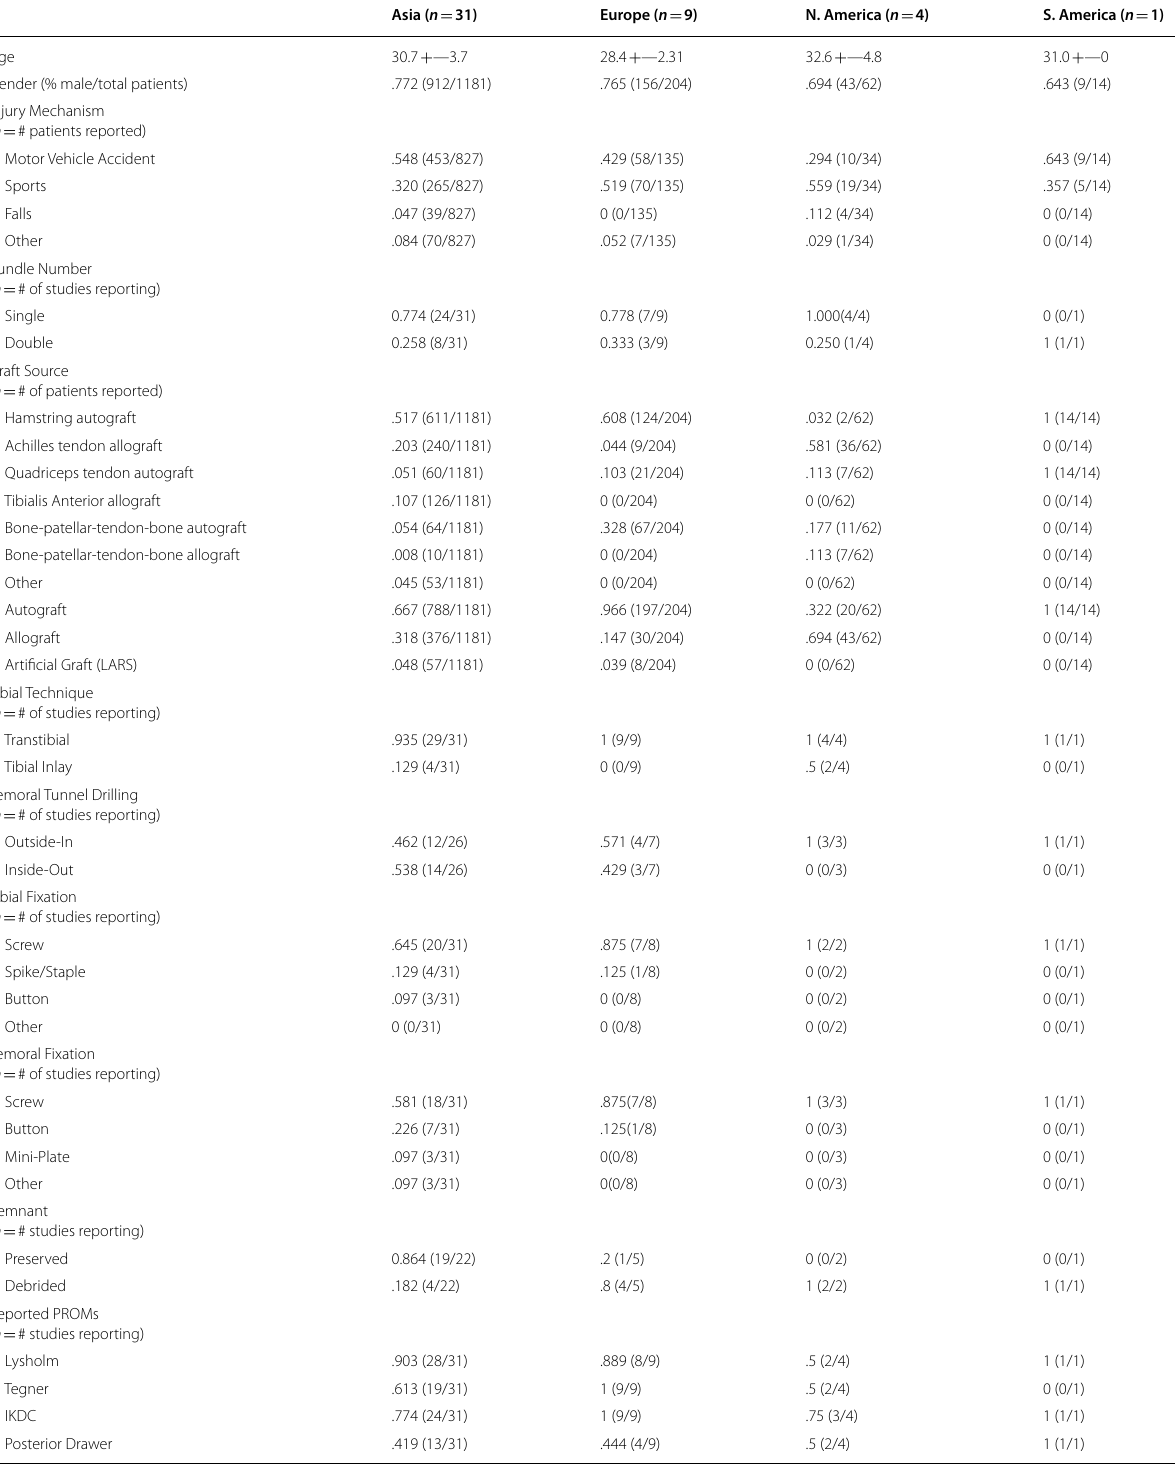
Legend : LARS Ligament Advanced Reinforcement System, PROM Patient reported outcomes measures, IKDC International Knee Documentation